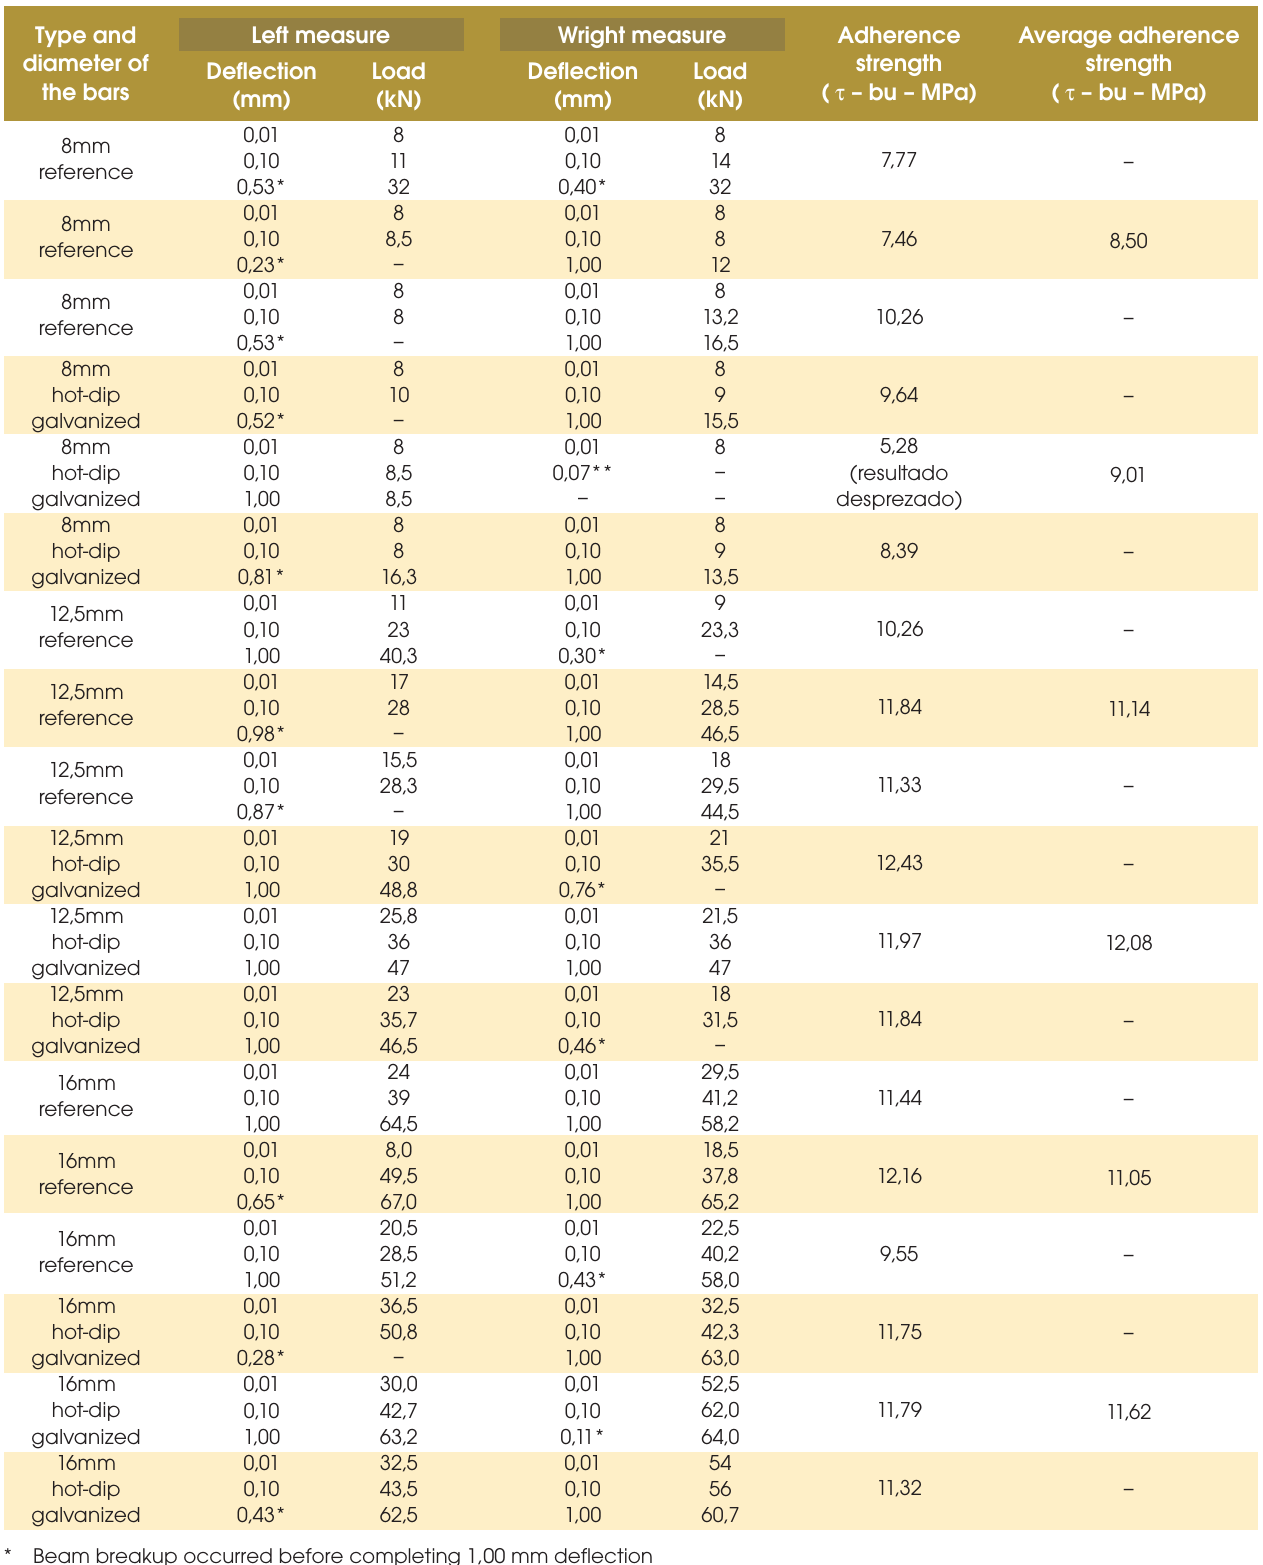
Table 4 – Values obtained from adherence